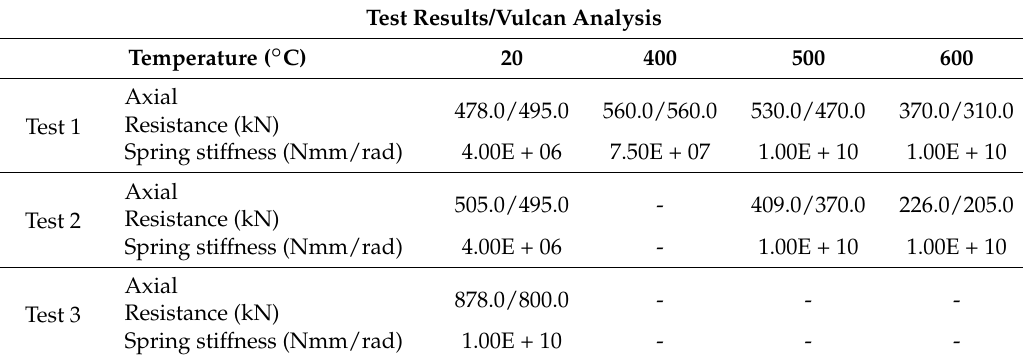
Table 3. Comparison between the test results of capacity tests with the numerical model.